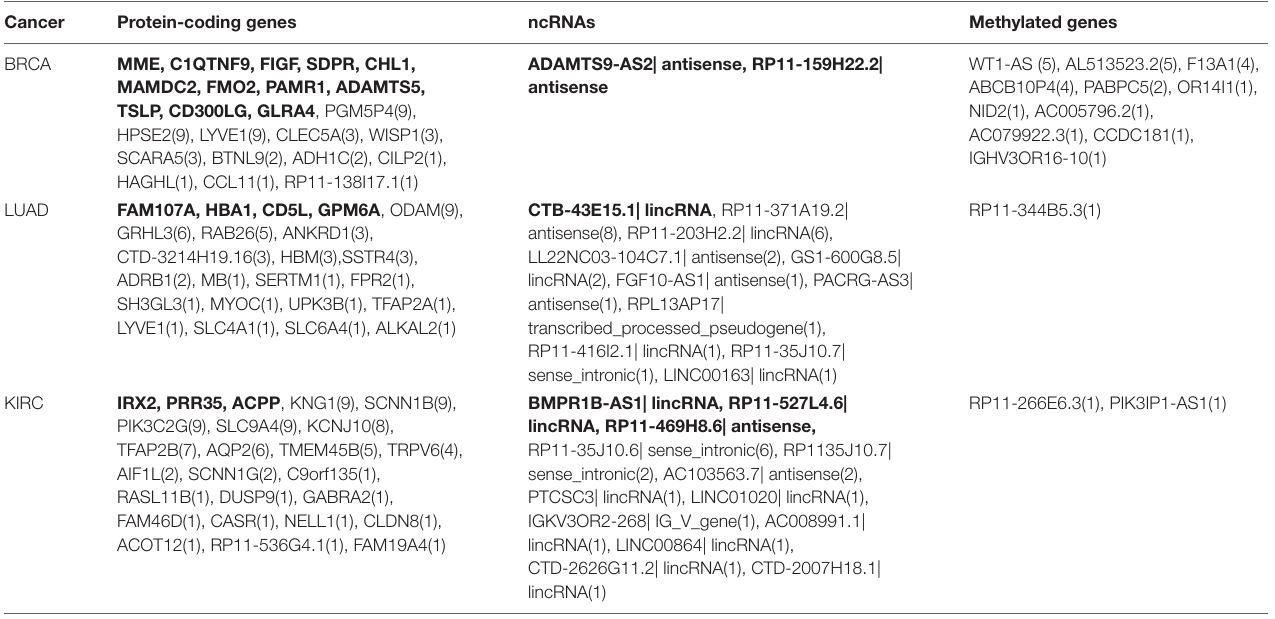
TABLE 5 | The summary of selected features for the three cancers. Cancer Protein-coding